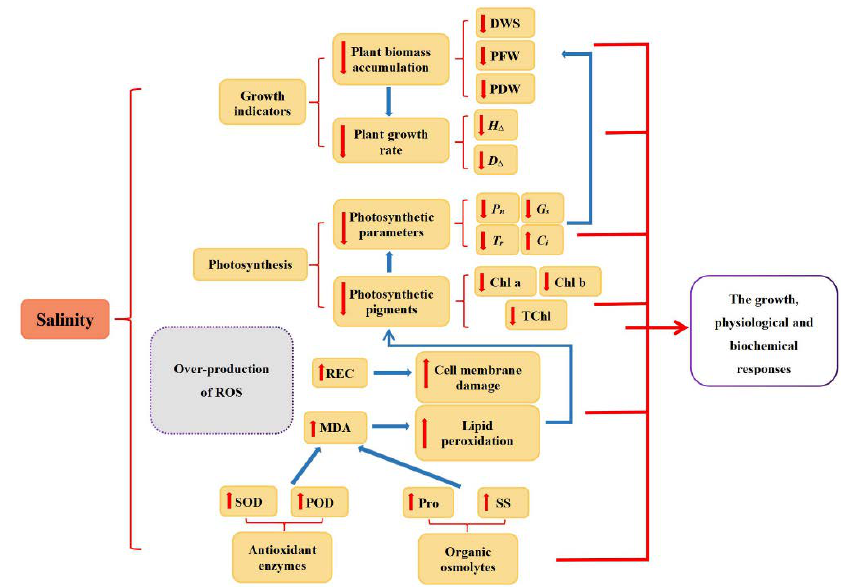
Figure 9. Schematic representation of salinity-induced growth inhibition. H ∆ , seedling height incre- ment; D ∆ , ground diameter increment; DWS, dry weight of shoot; PFW, plant fresh weight; PDW, plant dry weight; Chl a, chlorophyll a content; Chl b, chlorophyll b content; TChl, total chlorophyll content; P n , net photosynthetic rate; G s , stomatal conductance; T r , transpiration; C i , intercellular CO 2 concentration; MDA, malondialdehyde; REC, relative electrical conductivity; Pro, proline; SS, soluble sugar; SOD, superoxide dismutase; POD, peroxidase.